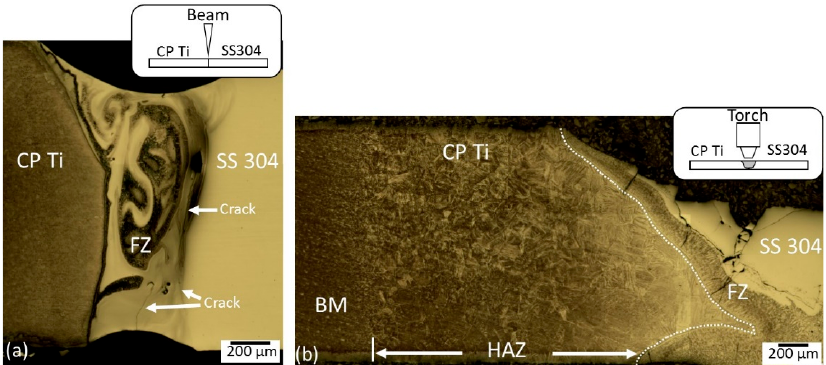
Figure 2. Low magnification optical micrographs showing weld profiles of ( a ) LBW and ( b ) GTAW. The dashed white line on ( b ) has been added to illustrate the boundary between fusion and heat-affected zones. Note: insets show schematic welding process for LBW and